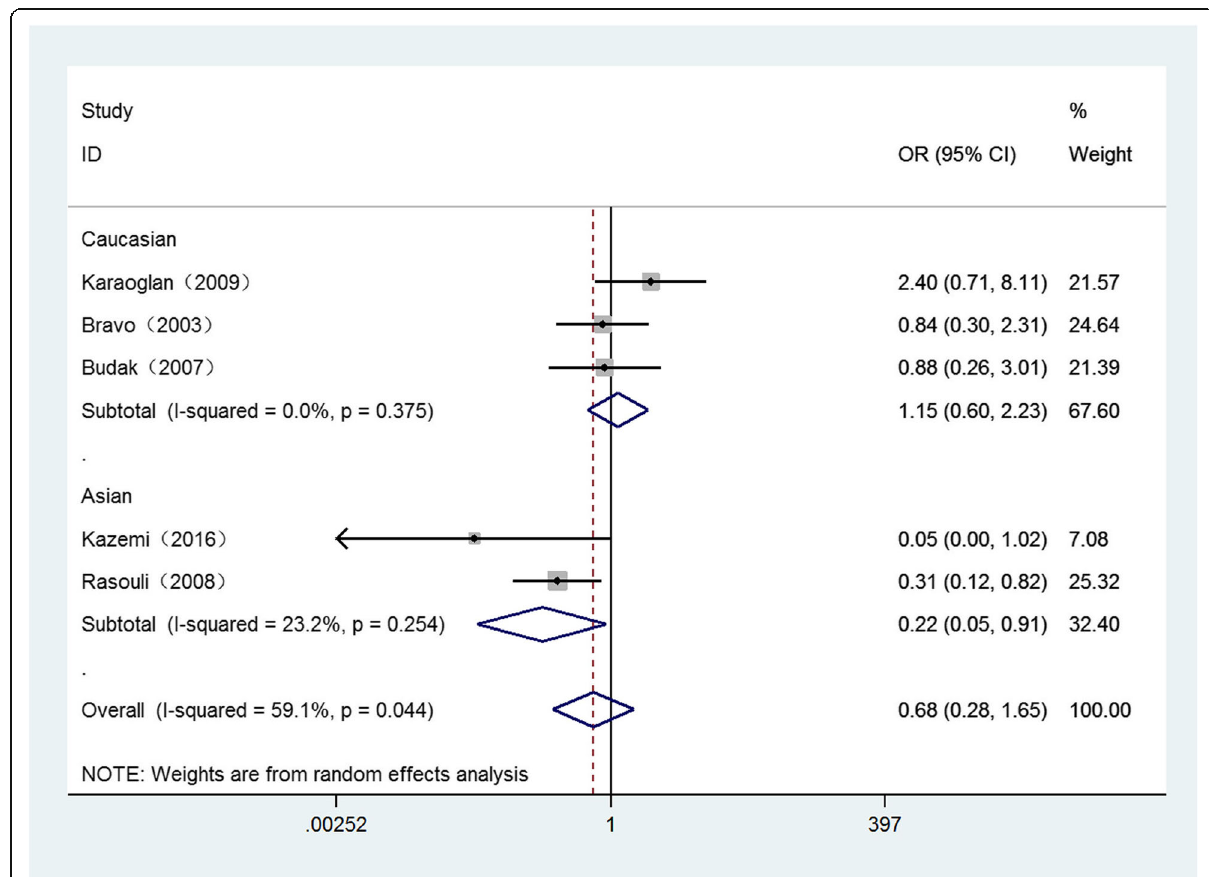
Fig. 4 Forest plot of IL-10 -819 C/T polymorphism on Brucellosis risk in recessive model (TT vs.